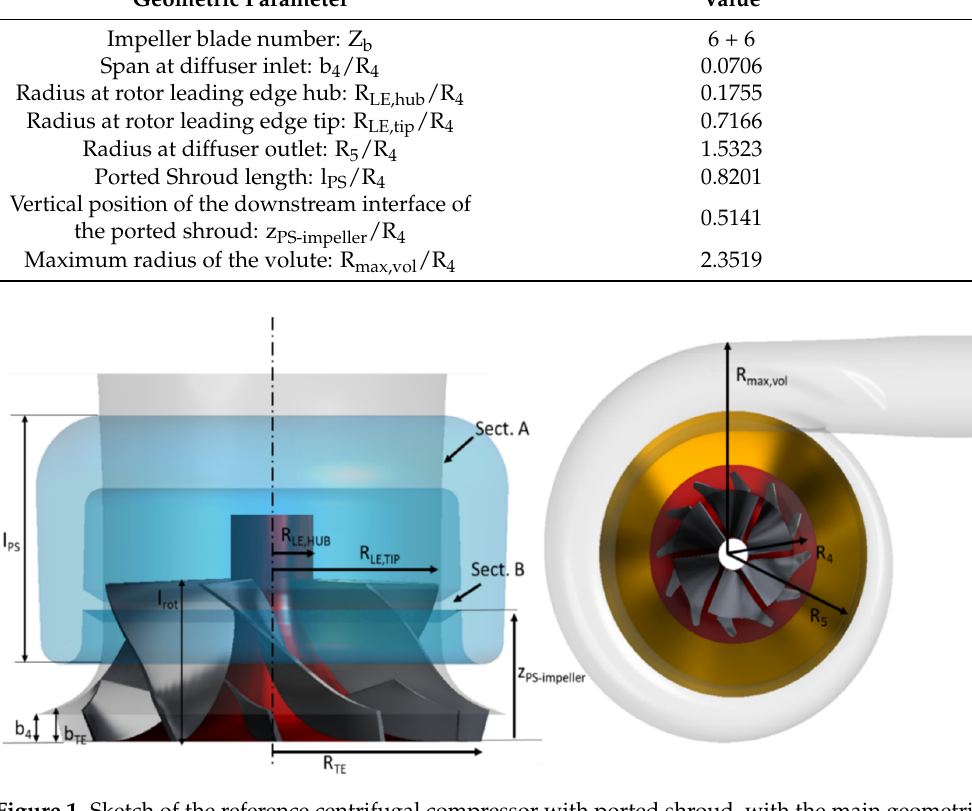
Figure 1. Sketch of the reference centrifugal compressor with ported shroud, with the main geometrical parameters.